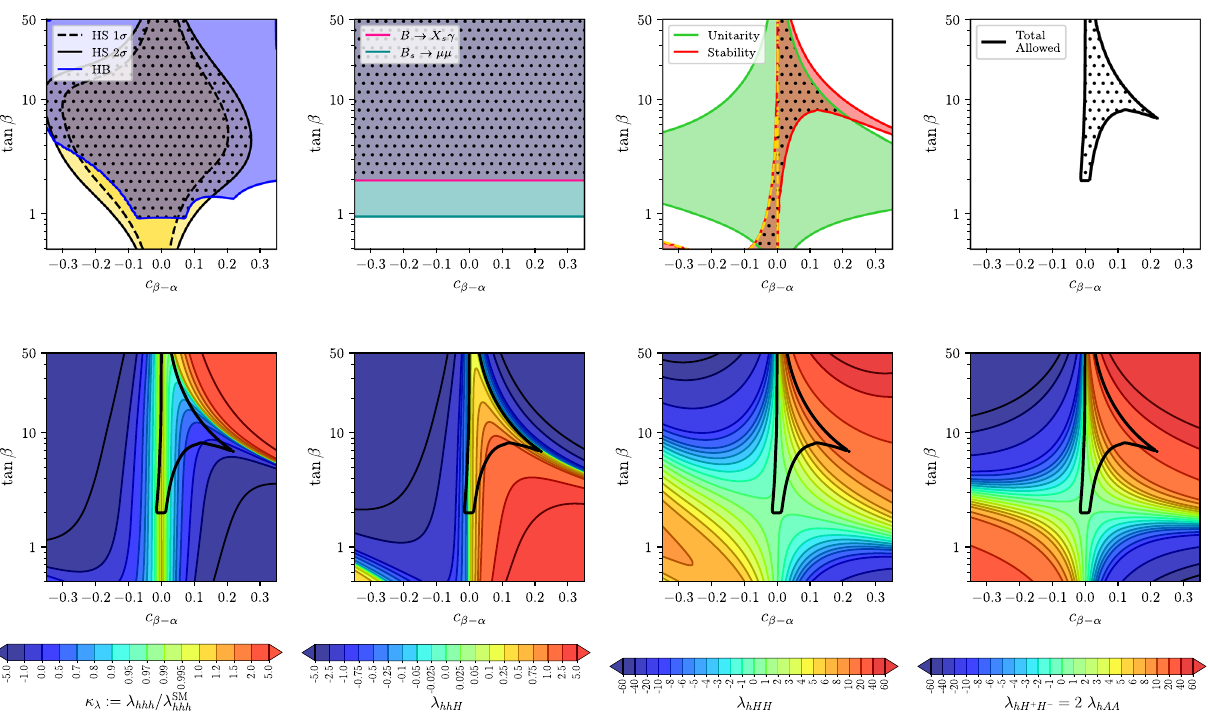
Fig. 4 Allowed areas (dotted regions) from the various constraints (upper row) and triple Higgs couplings (lower row) for the benchmark scenario I-1 in the c β − α –tan β plane with m 2 fixed via Eq. (6) and m = 1000 GeV 12